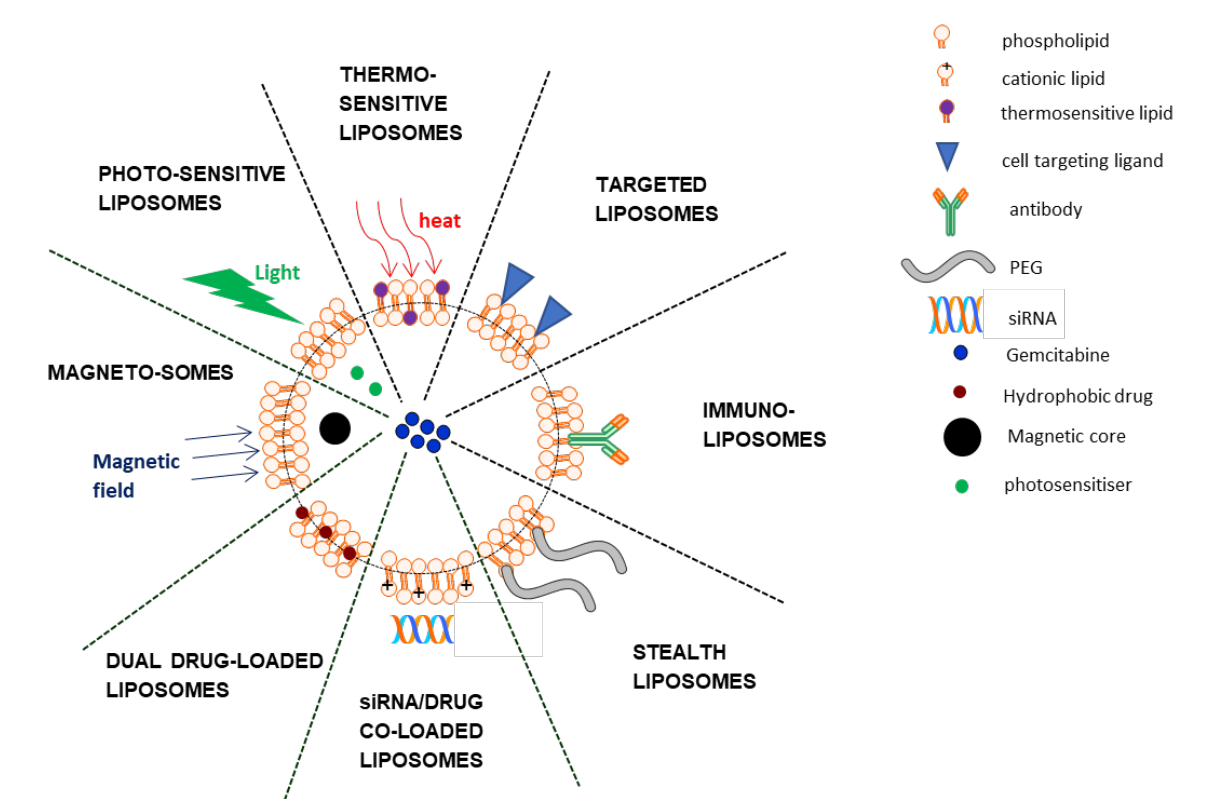
Figure 2. Schematic representation of some liposomal gemcitabine delivery systems.